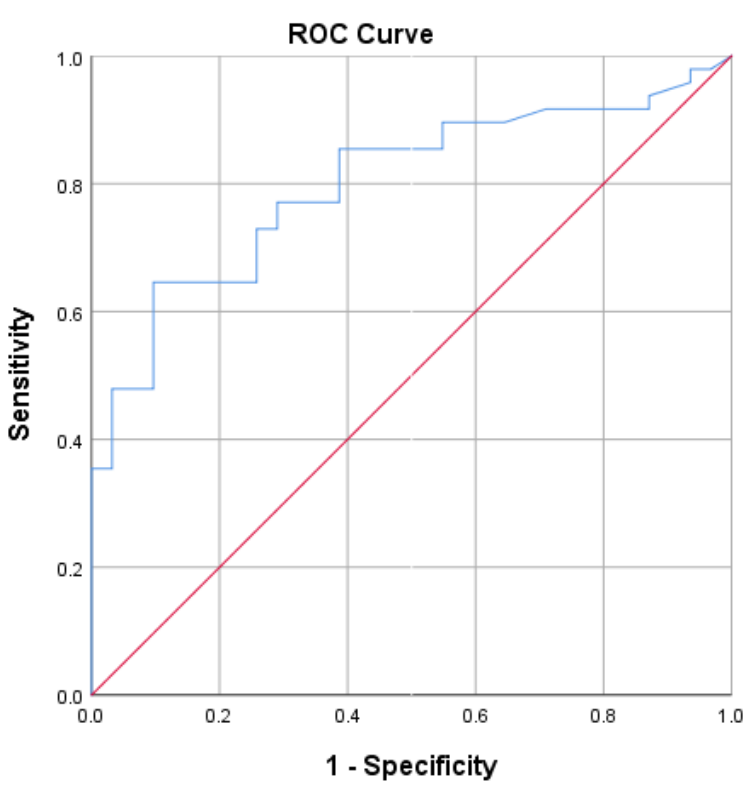
Figure 2. ROC chart, miR-377-3p in healthy and diseased